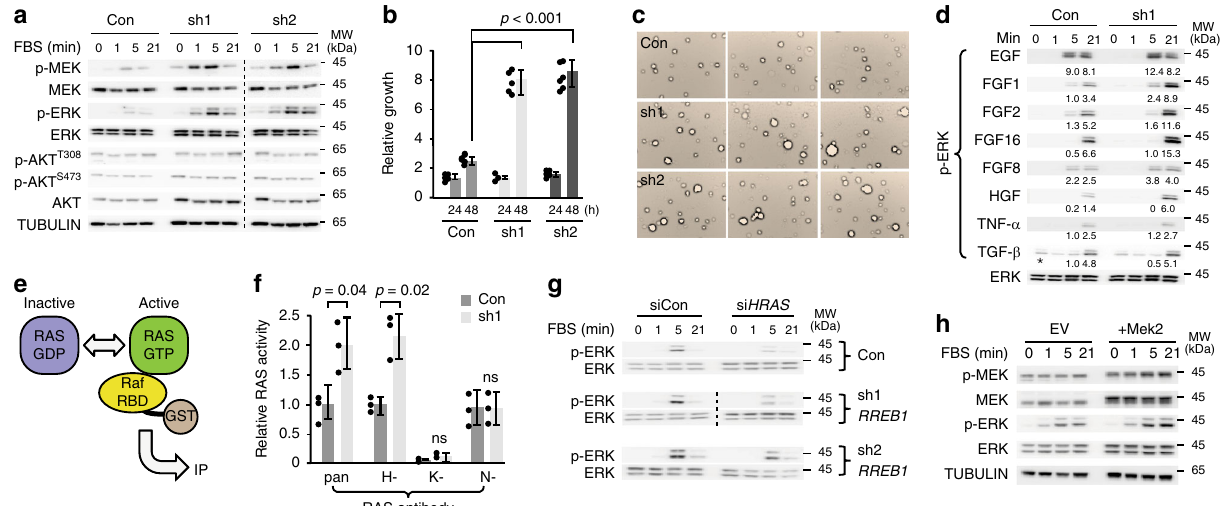
Fig. 4 RREB1 loss leads to increased sensitization of RAS-MAPK signaling. a Examination of MAPK and AKT signaling in HEK293 cells expressing control shRNA (Con) or shRNA (sh1 or sh2) targeting RREB1 following serum deprivation and stimulation with FBS at the indicated times. Dotted line separates different membranes ( n = 6). Tubulin served as a loading control. b Relative cell growth in culture measured by Alomar Blue ( n = 6, p = 9.5E-07 (Con vs. sh1), p = 5.4E-06 (Con vs. sh2), value two-tailed student ’ s t -test, error bars presented as mean values± SD) and c cell growth in soft agar ( n = 3) of HEK293 cells expressing sh-control (Con) or shRNA (sh1 or sh2) targeting RREB1 . d Western blot analysis of p-ERK activation in HEK293 cells expressing control sh-control (Con) or sh1 targeting RREB1 following stimulation with the indicated mitogens or cytokines. Total ERK blot is representative for all panels. Quanti fi cation (5 and 21 min) time points indicated, normalized to TGF- β treated zero time point (asterisk) ( n = 2). e Schematic of the RAS activation assay. RAS cycles between GDP (inactive) and GTP (active) bound forms. Active RAS can be trapped by af fi nity binding to the Raf-Ras binding